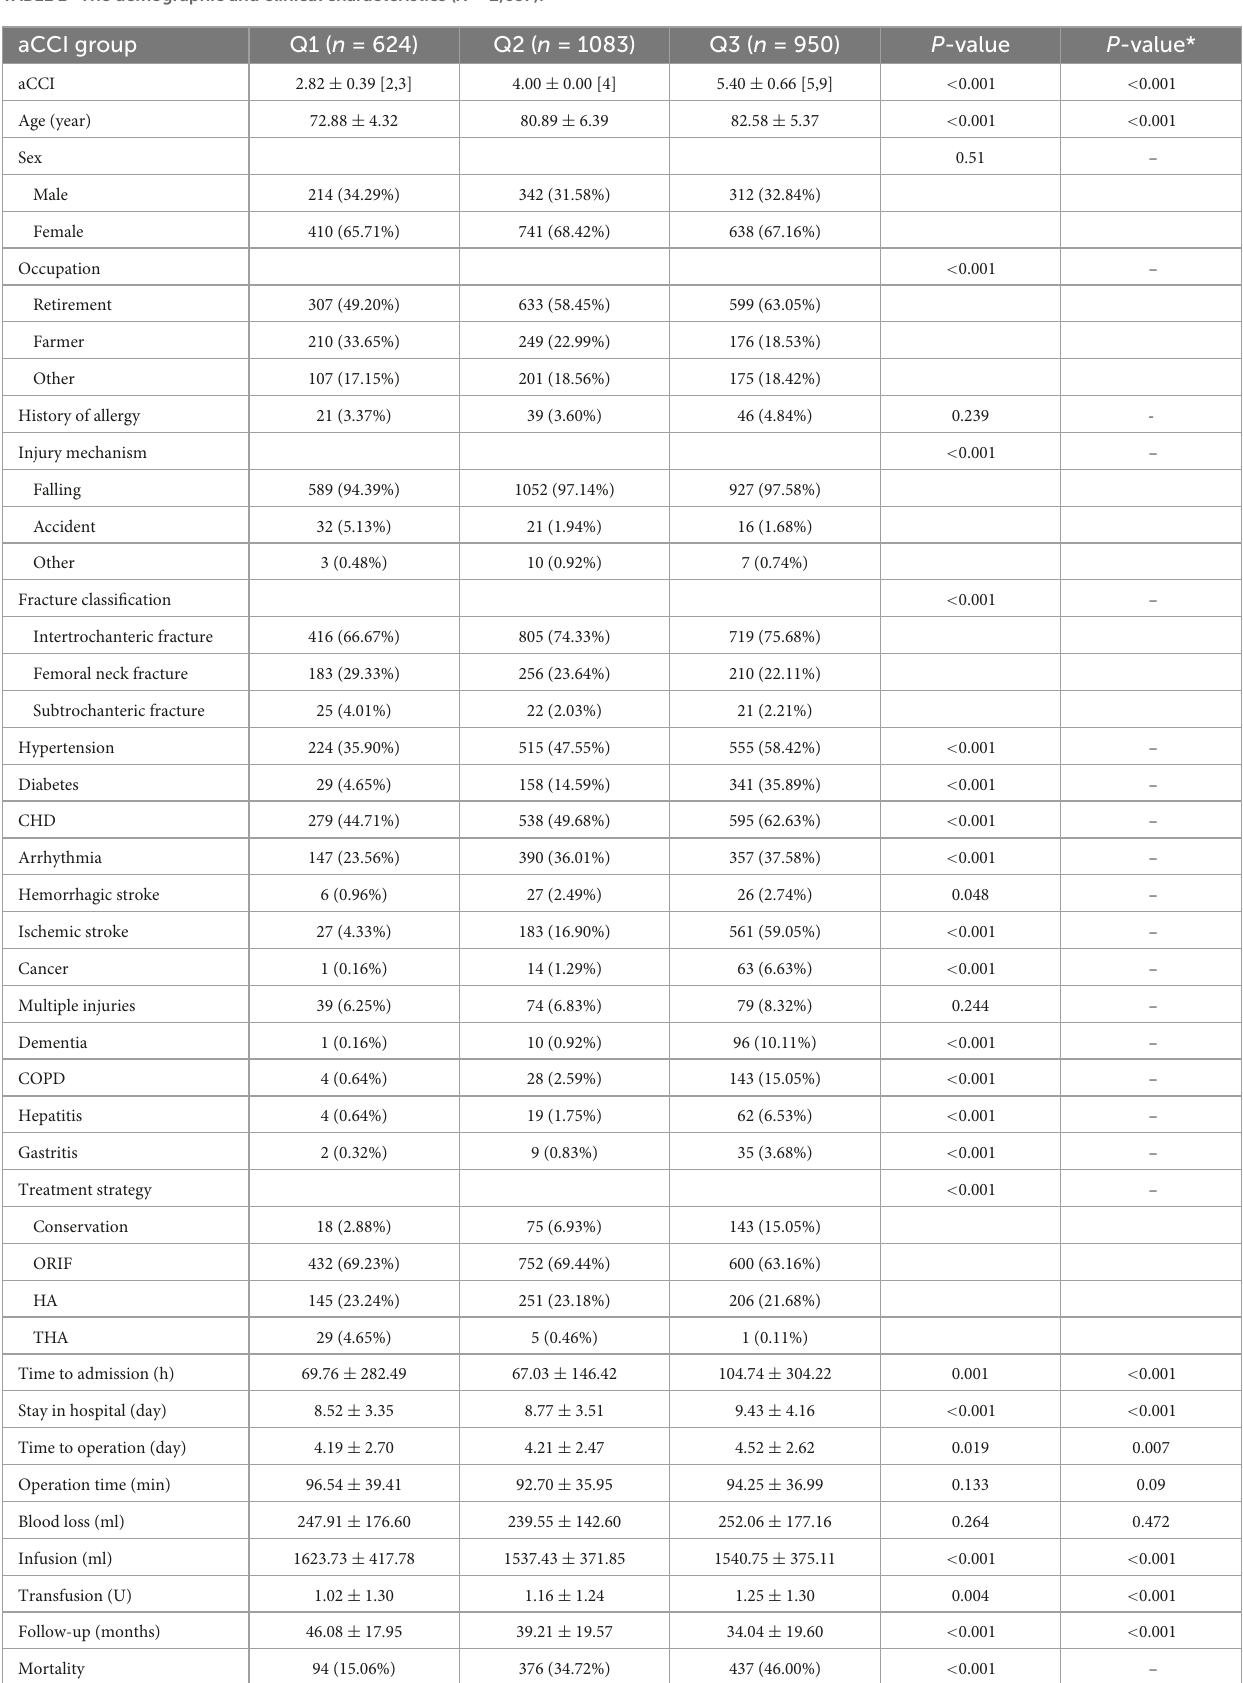
TABLE 1 The demographic and clinical characteristics ( N = 2,657).